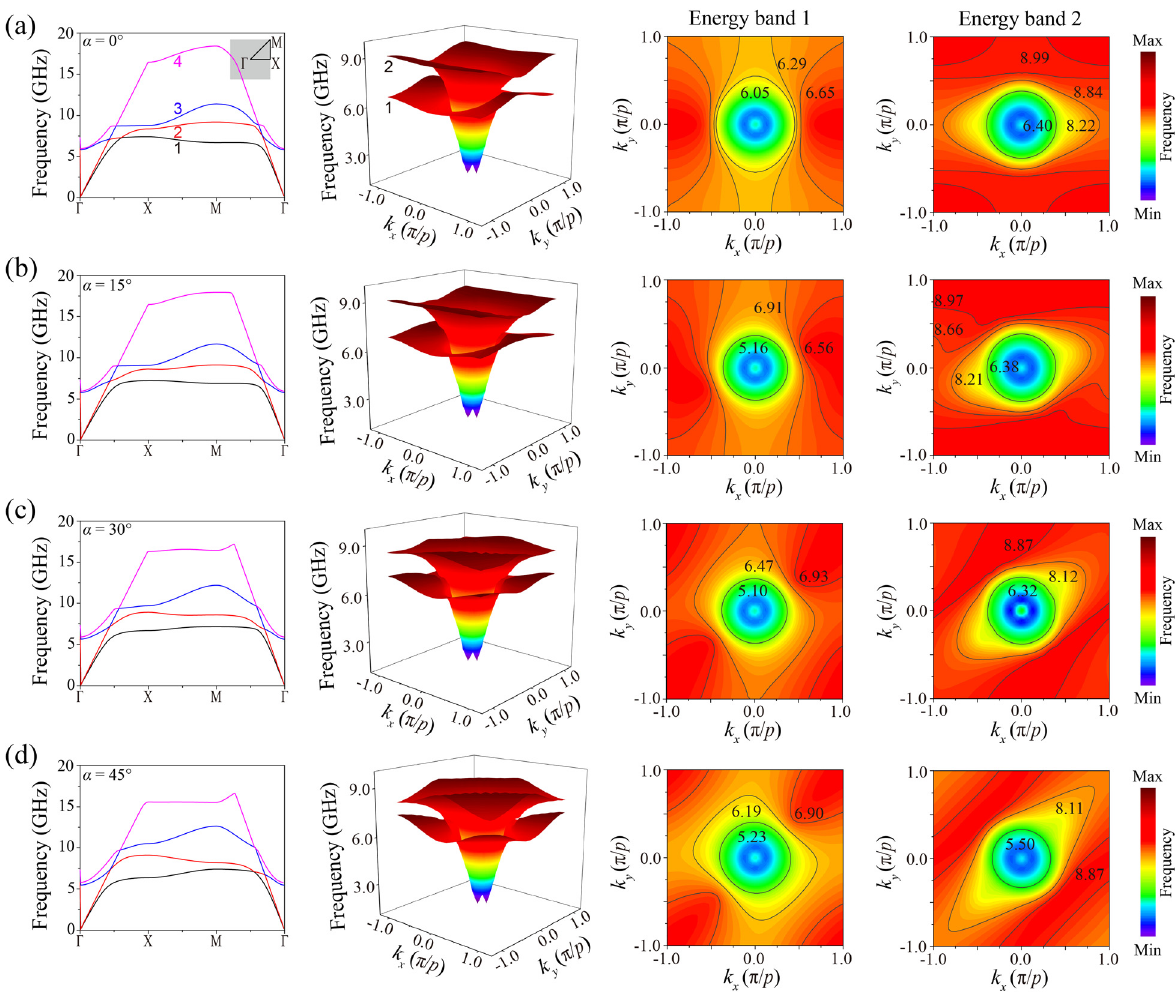
Figure2: The3Denergybanddiagrams/IFCsofthefirsttwobandsinthefirstBrillouinzonewhentherotationanglesare(a)0 ° (theinsetinthe band diagram illustrates the fi rst Brillouin zone and the highly symmetrical points), (b) 15 ° , (c) 30 ° , and (d) 45 ° , respectively. The unit of the frequency values in the IFCs is